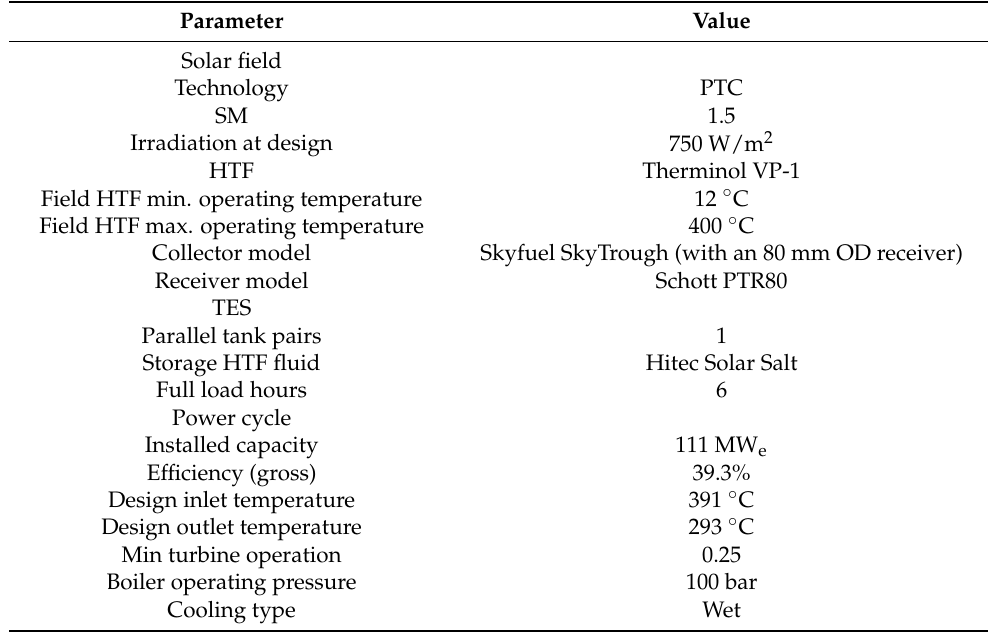
Table 2. Technical parameters of CSP